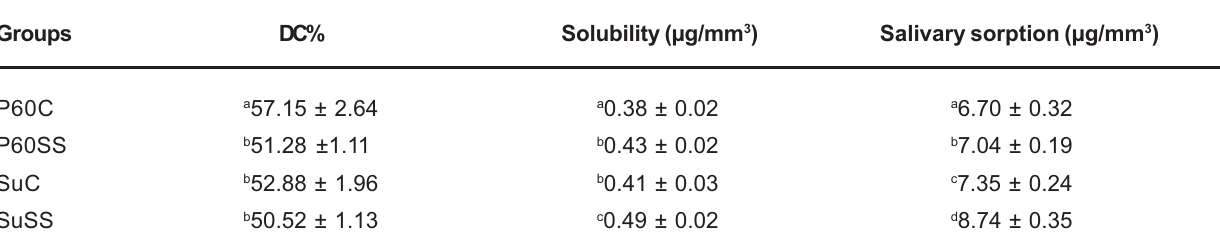
Within each column, values with same superscript letters are not statistically different ( α = 0.05).